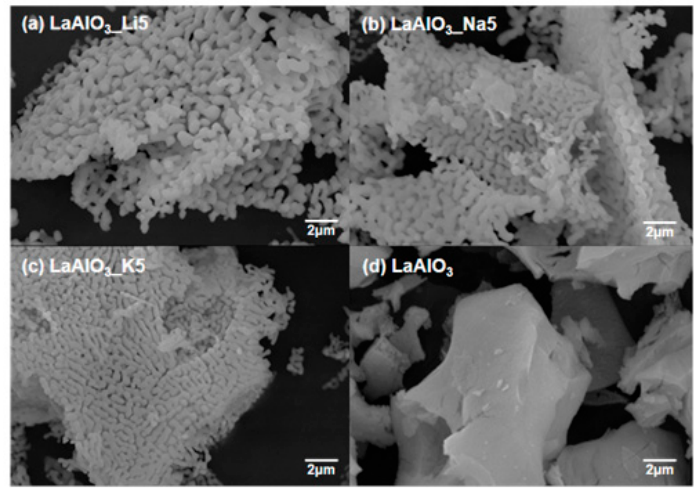
Figure 4. Field emission scanning electron microscopy images (FE-SEM) of LaAlO 3 _X5 (X = Li, Na, K) and LaAlO 3 catalysts: ( a ) LaAlO 3 _Li5, ( b ) LaAlO 3 _Na5, ( c ) LaAlO 3 _K5, and ( d ) LaAlO 3 .